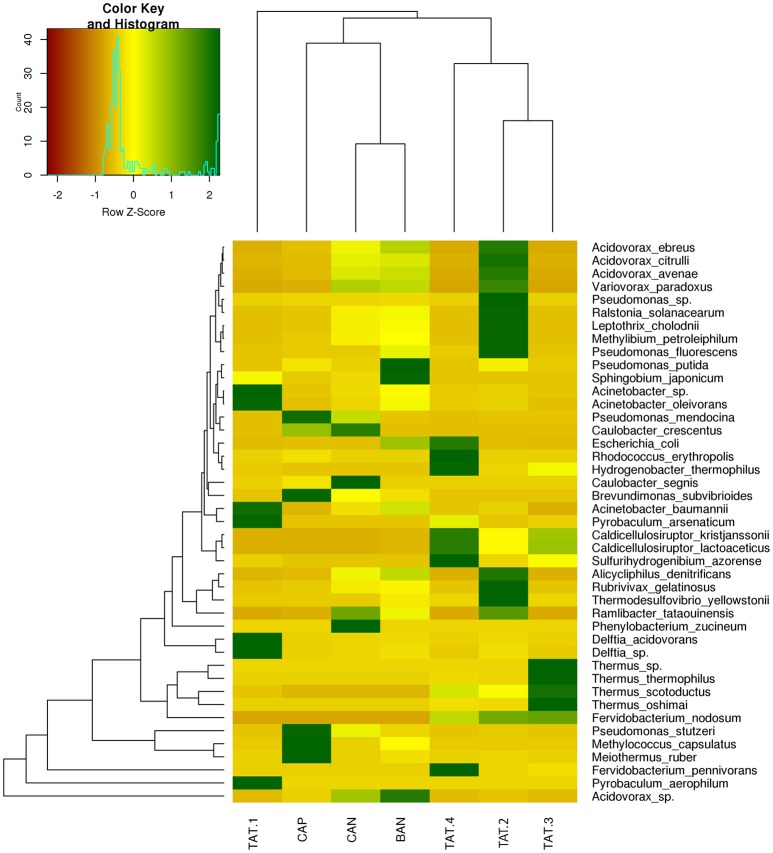
Heatmap showing relative abundance of species. Species with ≥ 5% abundance in each WGS sample are plotted on heatmap. The dendrograms show hierarchical clustering between species and samples.